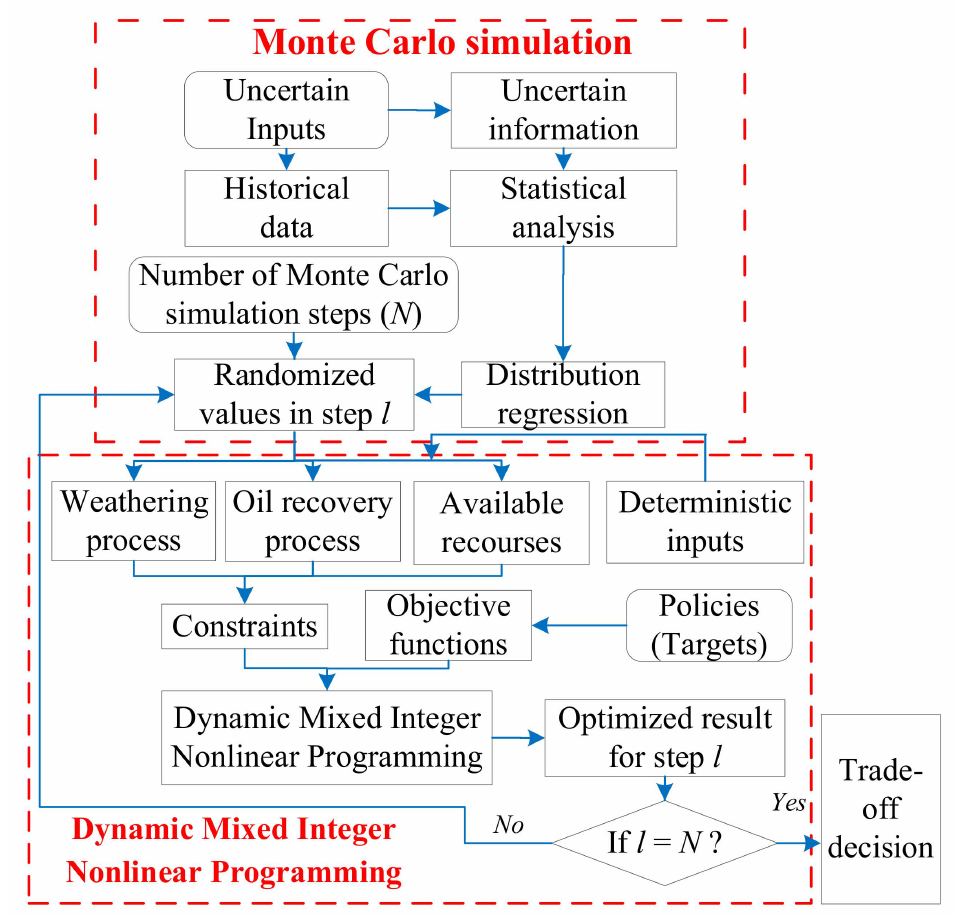
Figure 4. Framework of the MC-DMINP approach (adopt from Li et al. (2014)